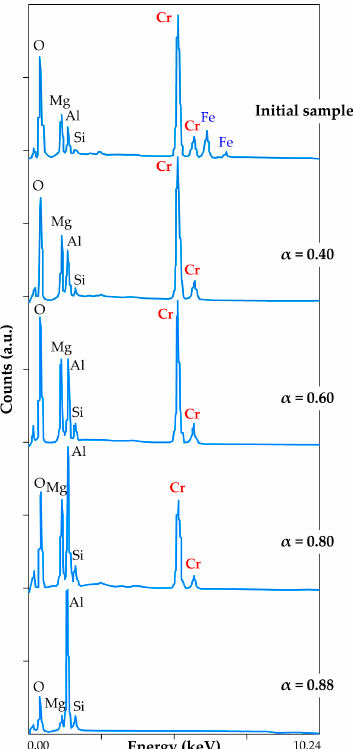
Figure 14. SEM-EDS results of residue from the oxychlorination of HGChC at different α -values. Distinct characteristic peaks of Cr, Mg, Al, Fe, Si and O are present in the SEM-EDS spectrum of the initial sample, in good agreement with the HGChC elemental composition afore-mentioned in Figure 3. The product corresponding to the fraction reacted α = 0.40 does not contain iron. As iron bearing compounds of the chromite body are FeO · Fe 2 O 3 and FeO · Cr 2 O 3 , the SEM-EDS analysis of the fraction reacted at α -0.40 is an indirect confirmation for the removal of magnetite and iron chromite from the HGChC. Spectra at α = 0.60 and α = 0.80 with their decreasing chromium peak